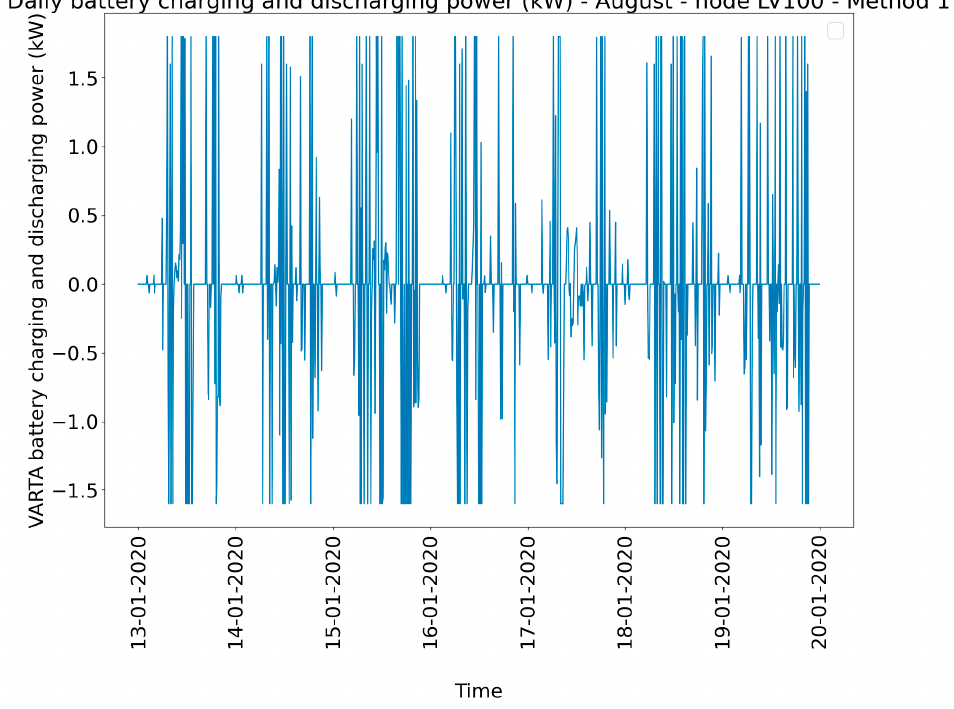
Figure A5. VARTA battery charging and discharging curve—January—Method 1.